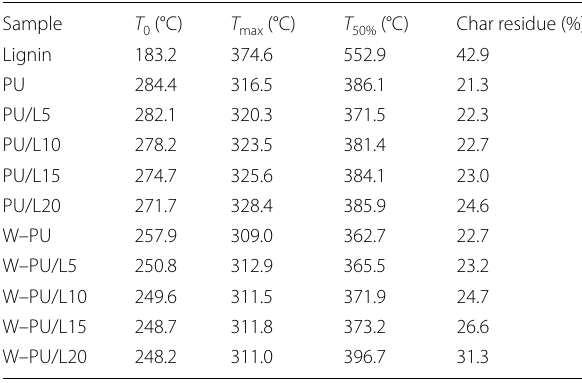
Table 4 Thermogravimetric parameters of PU and W–PU foams containing varying contents of lignin